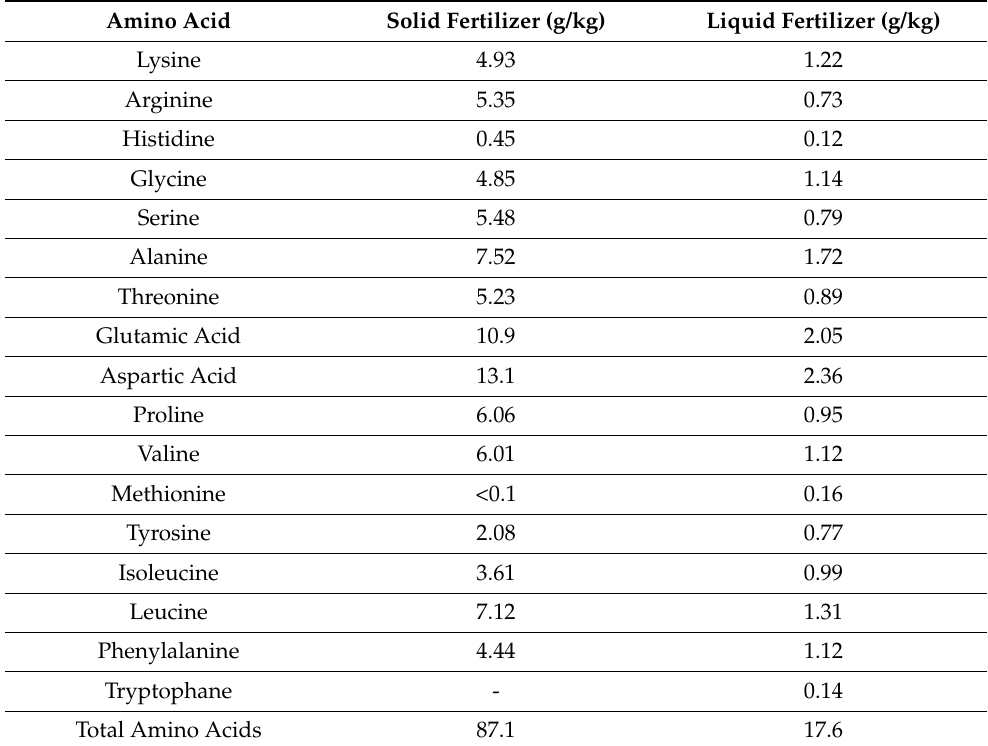
Table 7. Amino acid concentration of liquid fertilizer (UF reject) against the solid fertilizer (Decanter Centrifuge).